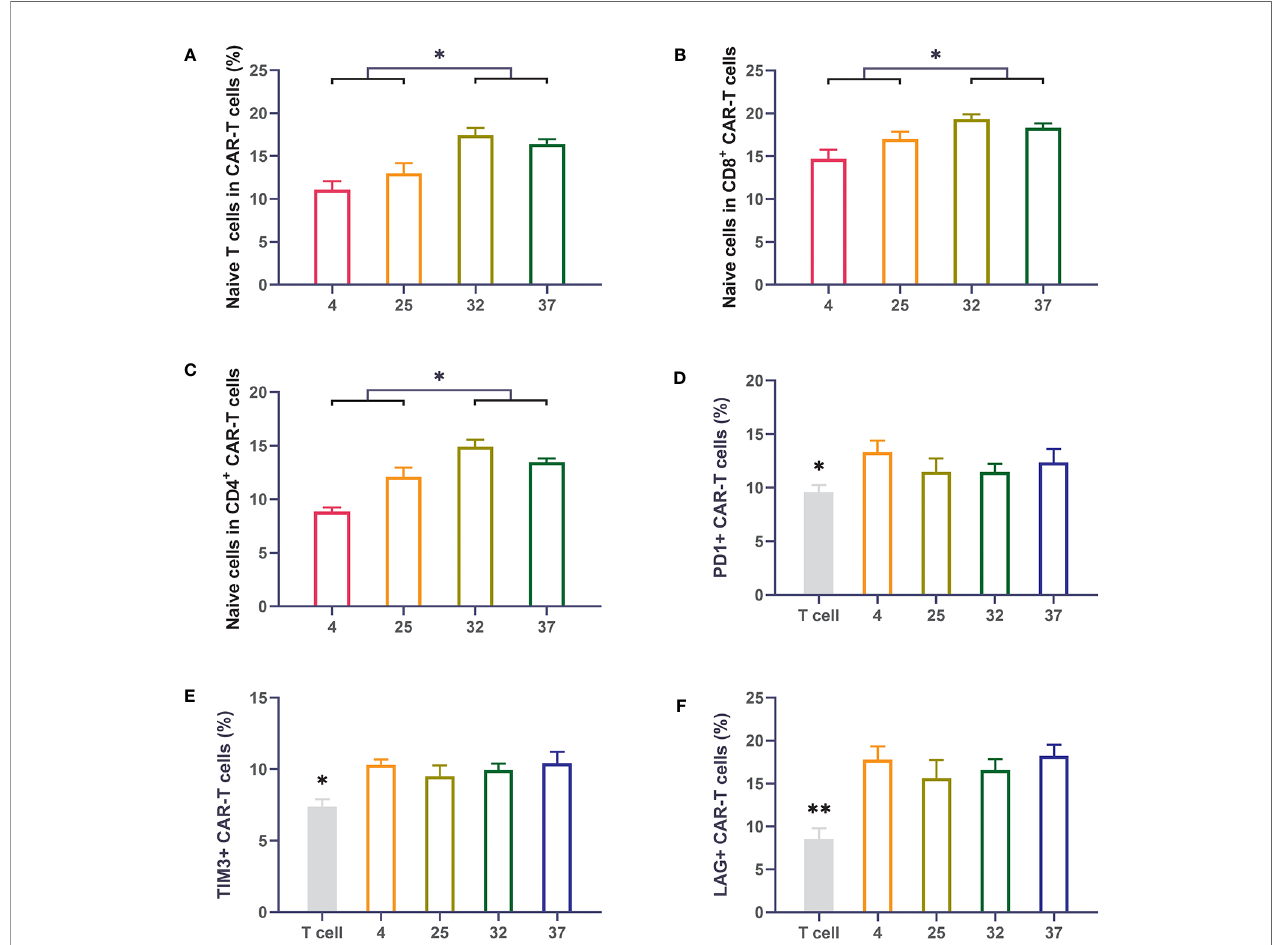
FIGURE 3 | Infection temperature can affect the proportions of CD19 CAR-T cell subsets and the expression of immune checkpoints (A – C) The proportion of naive T cells among CD3-positive, CD8-positive and CD4-positive CD19 CAR-T cells generated at different infection temperatures. (D – F) The expression of PD1, TIM3, and LAG3 on the surface of CD19 CAR-T cells generated at different infection temperatures. Three independent experiments were conducted. Mean ± SD. *p < 0.05, **p <